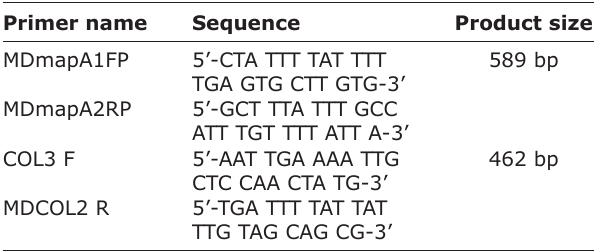
Table-1: Sequence of primers used in PCR for C. jejuni and C. coli .